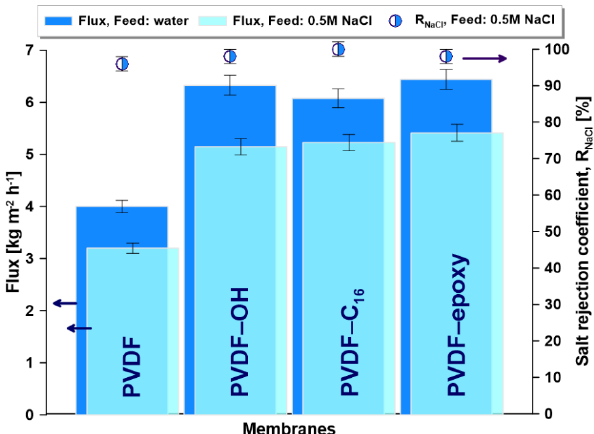
Figure 6. Membrane performance in the desalination process of